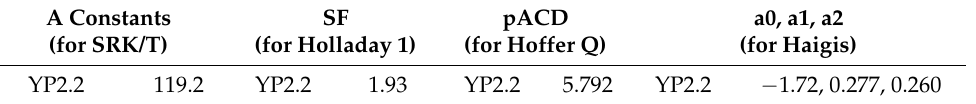
Table 2. Optimized Constants for IOL power calculation